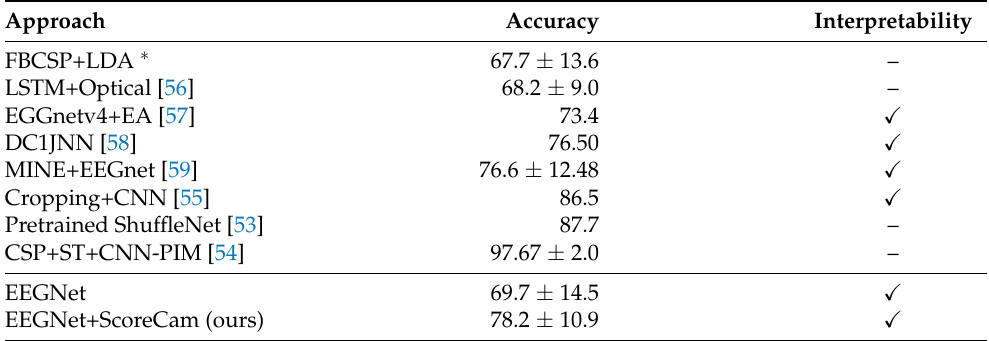
Table 2. Comparison of bi-class accuracy achieved by state-of-the-art approaches in GigaScience collection. ∗ The baseline approach (FBCSP+LDA) using conventional pattern recognition methods is also reported for comparison. The proposed CNN-based approach introducing spatiotemporal ScoreCAMs is competitive (marked in